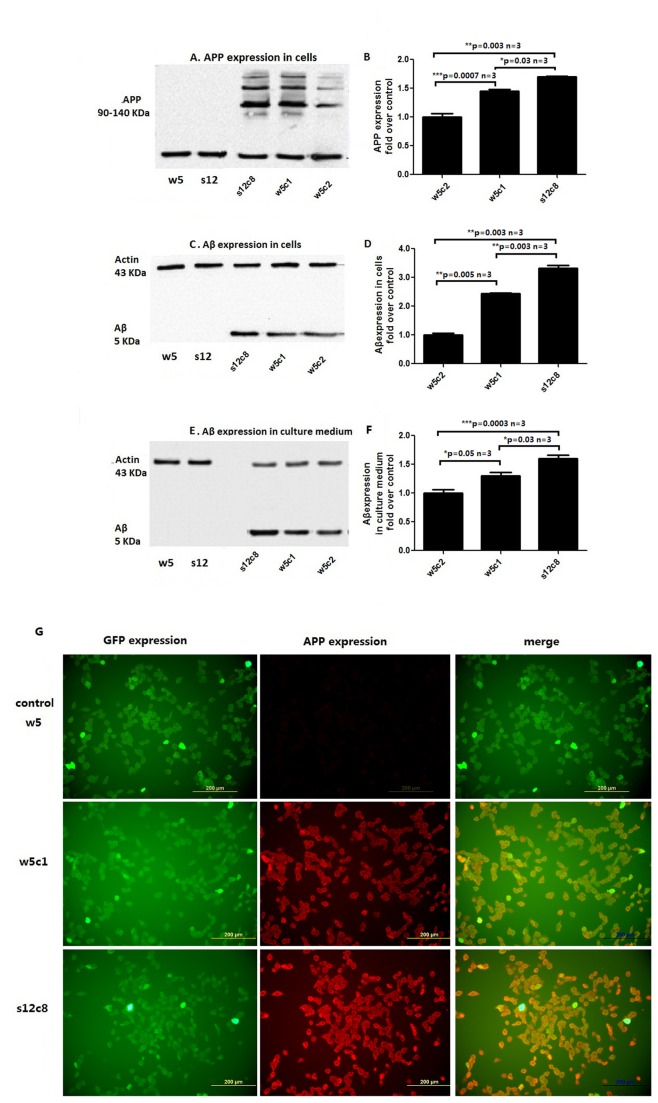
APP and Aβ expression in engineered cell lines.W5c1 and w5c2 are wildtype hAPP knock-in cell lines, while cell line s12c8 contains the hAPP sequence with the Swedish double mutation. (A) Top: Representative Western blot of homogenates of hAPP knock in cell lines using the human anti-APP Thr668 antibody (CST, #2452). Bottom: Representative Western blot for β-actin (CST, #4967) in the cell lines. APP expression was not detectable in cell lines w5 and s12. (B) Quantitation of the expression level of APP in cells. (C) Representative Western blot of cell homogenates from APP knock in cell line performed with mAb specifically recognizing Aβ isoforms (CST, #2454). (D) Quantitation of the expression level of Aβ in cells. (E) Representative Western blot of Aβ released into the cell media using mAb specifically recognizing Aβ isoforms (CST, #2454). While actin is found in the culture medium this likely is from dead cells. The ratio of Abeta/actin is higher in media (1.6:1) than in cells (1.1:1). This suggests that at least some of the Abeta were released from living cells. (F) Quantitative analysis of Aβ expression level in the cell culture medium. Results presented in B, D, and F were obtained from three independent experiments, each performed in triplicate and are expressed as mean ± SD. (G) Colocalization of GFP with APP using immunofluorescence. Green fluorescence protein (GFP, green) and Amyloid Precursor Protein (APP) immunoreactivity (red) co-localized in cell lines w5, w5c1 and s12c8. Cells from cell line w5 are positive for GFP but negative for APP. Scale bars=200µm. Asterisk indicates a statistically significant difference between two groups (*p<0.05, **p<0.01, ***p<0.001).